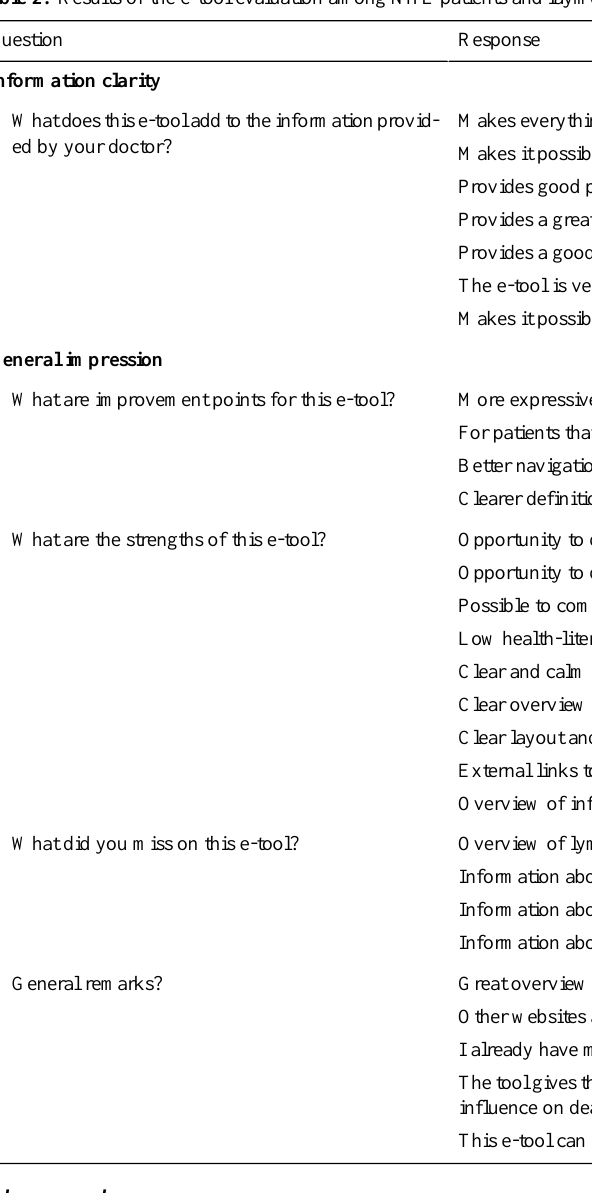
Table 2. Results of the e-tool evaluation among NHL patients and laymen (open-ended